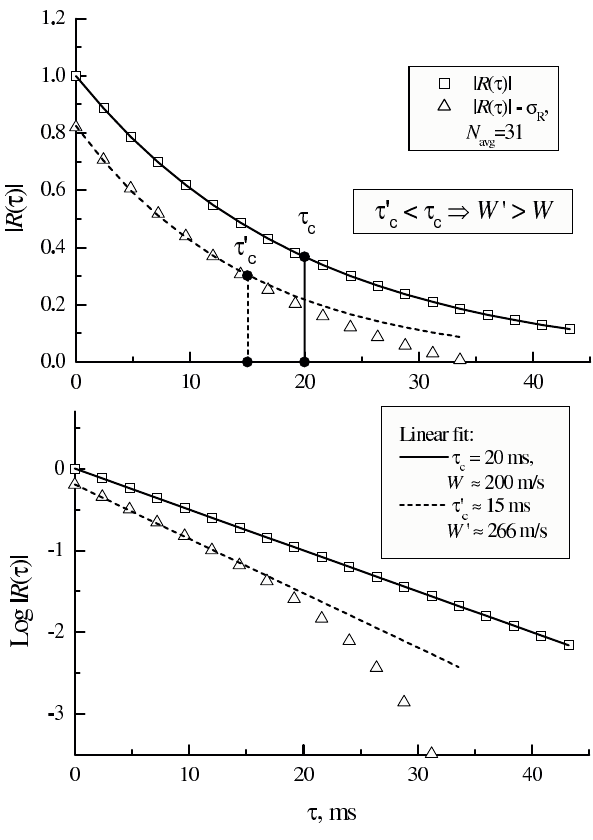
Fig. 4. Illustration of the overestimation of W due to the extrac- tion of the statistical fluctuation level, σ r = R( 0 )/ p N avg , from ACF power in